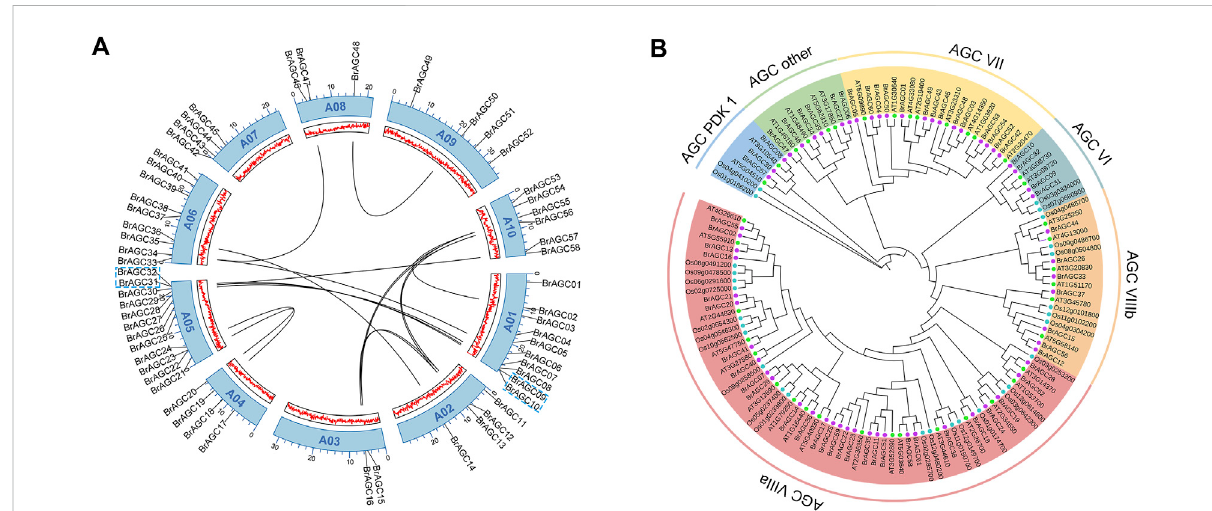
FIGURE 1 Chromosomelocalizationandphylogeneticanalysisof BrAGC genes (A) Genedistributionandduplicationeventsof BrAGC genes.Thegrayline isthesegmentallyduplicatedgenepair,andthetandemlyduplicatedgeneisindicatedbybluedottedlines. (B) Phylogenetictreefromthemaximum likelihood analysis of the AGC gene family in B. rapa , A. thaliana , and O. sativa